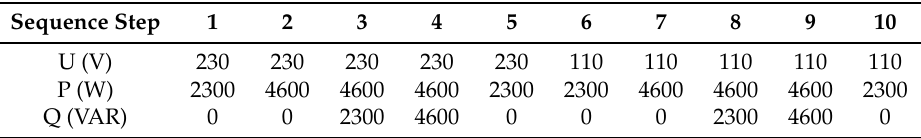
Figure 12. Example of analysis of measurement delays: Histogram and fitted distribution probability of delay between measurement creation and database storage ( left ) and cumulative distribution of measurement delays ( right ) for ( a ) PMU #1 and ( b ) PMU #3. Table 2. Opal-RT/FPGA power output sequence for